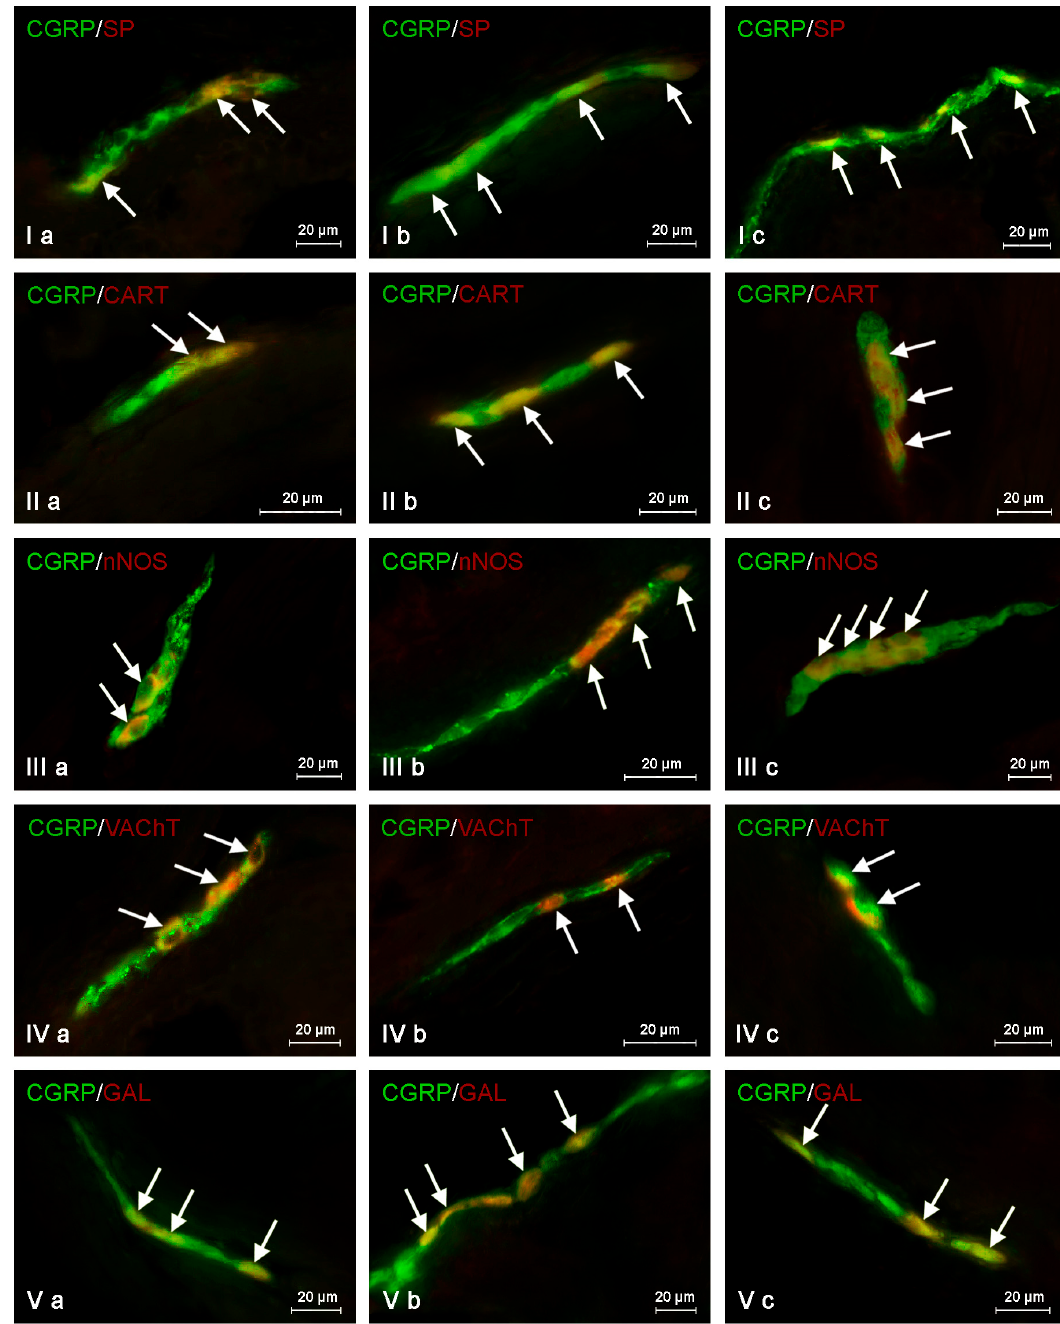
Figure 5. Representative images of the co-localization of calcitonin gene related peptide (CGRP) with other neuronally-active substances in the neurons of the inner submucous plexus of the porcine descending colon under physiological conditions ( a ), after axotomy ( b ) and during inflammation ( c ). (I) Co-localization of CGRP with substance P (SP); (II) co-localization of CGRP with cocaine- and amphetamine-regulated transcript (CART) peptide; (III) co-localization of CGRP with the neuronal isoform of nitric oxide synthase (nNOS); (IV) co-localization of CGRP with vesicular acetylcholine transporter (VAChT); (V) co-localization of CGRP with galanin (GAL). Images are composites of merged images taken separately from green (CGRP) and red (other substances studied) fluorescent channels. Nervous structures where CGRP co-localizes with other substances are indicated by arrows.